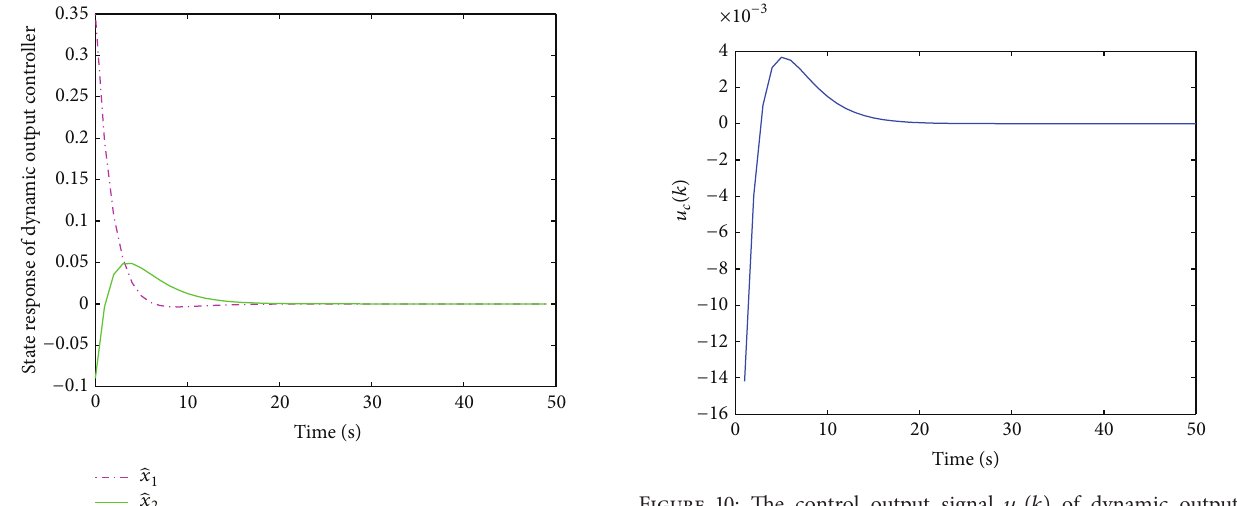
Figure 10: The control output signal 𝑢 𝑐 (𝑘) of dynamic output controller.